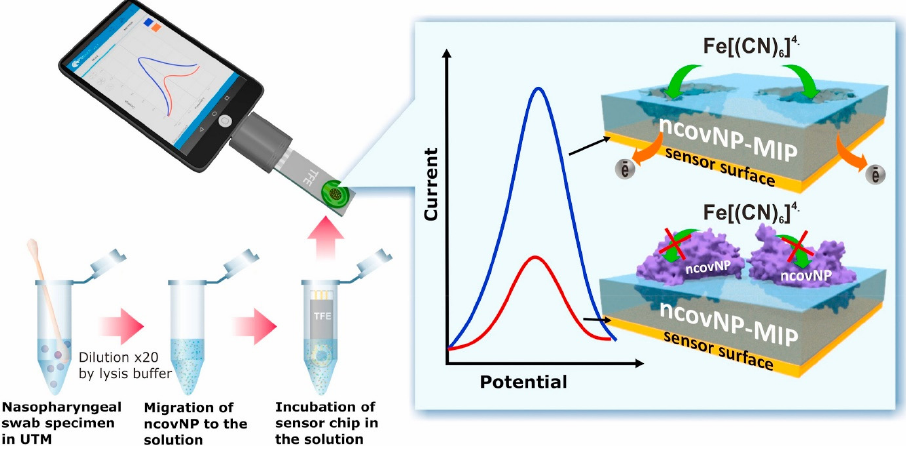
Figure 7. Concept of the clinical feasibility of the nconNP sensor analyzing the samples prepared from nasopharyngeal swab specimens. Reprinted with permission from [112]. Copyright 2021 Else ‐